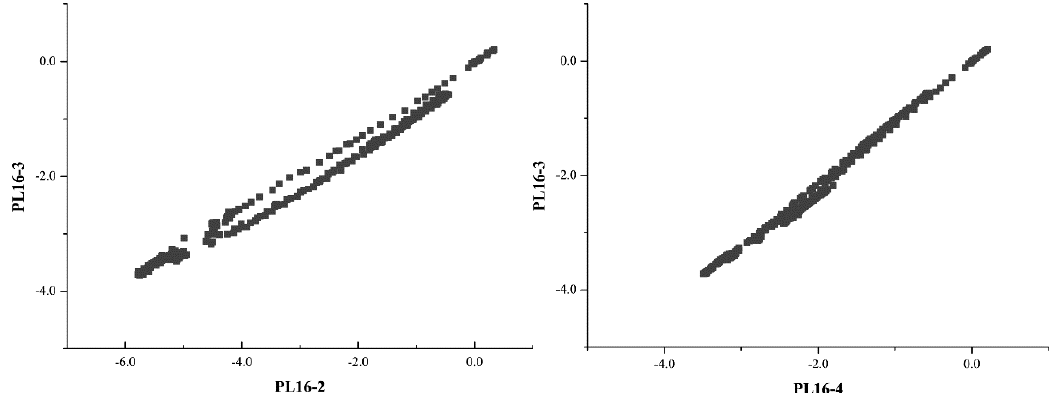
Figure 10. Distribution diagram of correlation between measuring points.